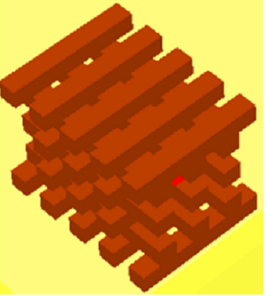
Figure 3. The arrangement of the wood pile and the location of initial ignition.